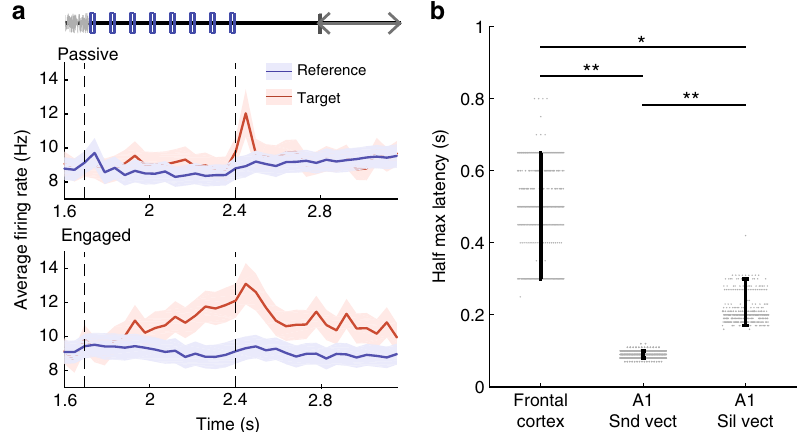
Fig. 6 Persistent, asymmetric response to target and reference stimuli in frontal cortex a Average PSTHs of all frontal cortex units in response to target and reference stimuli in both passive and engaged conditions. Note that the response to the target in the task-engaged state is very clear and appears late during the sound. Error bars: SEM over all units ( n = 102). b Latency to half-maximum response for frontal cortex (for average PSTHs) and primary auditory cortex (for projected target-elicited data) in the task-engaged state. For the auditory cortex, data is projected either on the sound decoding vector or the silence decoding vector. Error bars represent 95% con fi dence intervals. (400 cross-validations. p ≤ 0.0025, p ≤ 0.0025 and p = 0.011; ** p < 0.01; * p < 0.05). Note that all analysis in this fi gure is done after excluding lick-responsive units in A1 as described in Fig.